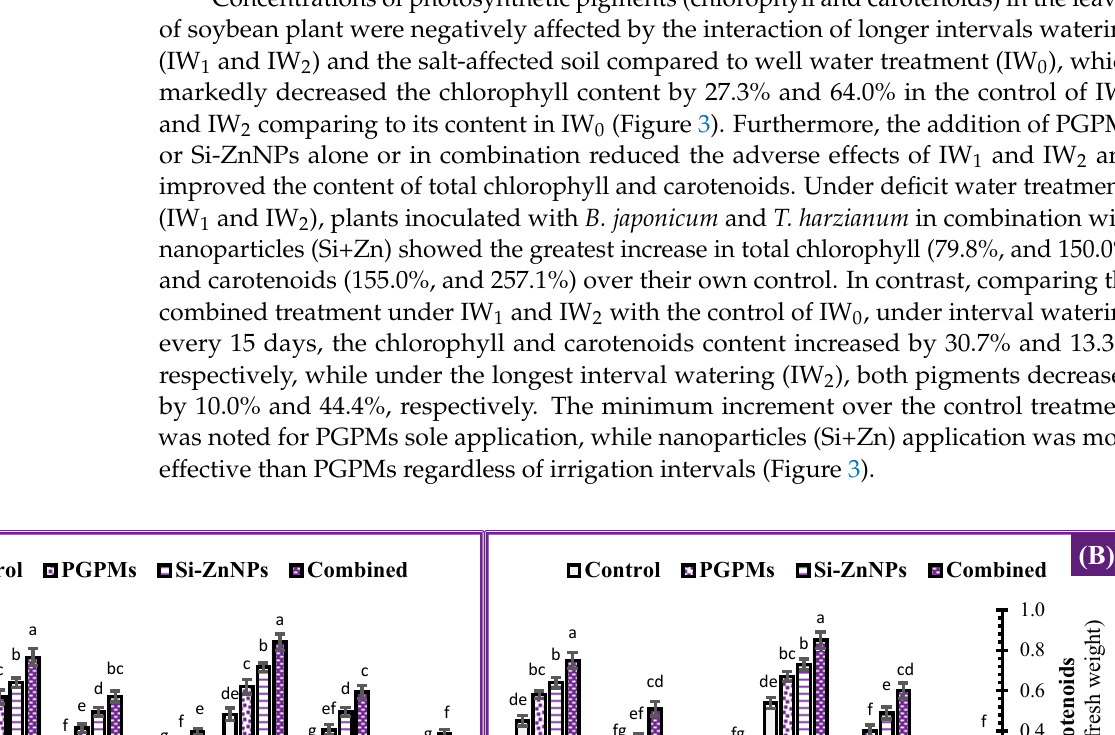
Figure 2. Influence of application of PGPMs, Si-ZnNPs and their combination on the concentration of ( A ) sodium (Na + ), and ( B ) potassium (K + ) in the leaves of soybean plant grown in salt-affected soil with different levels of watering inter- vals ( IW 0 ; 11 days, IW 1 ; 15 days, and IW 2 ; 19 days) during the successive 2019 and 2020 growing seasons. The data pre- sented as means ± SD. Means labeled with the same lower-case letter are not significantly different according to Dun- can’s Multiple Range Test.